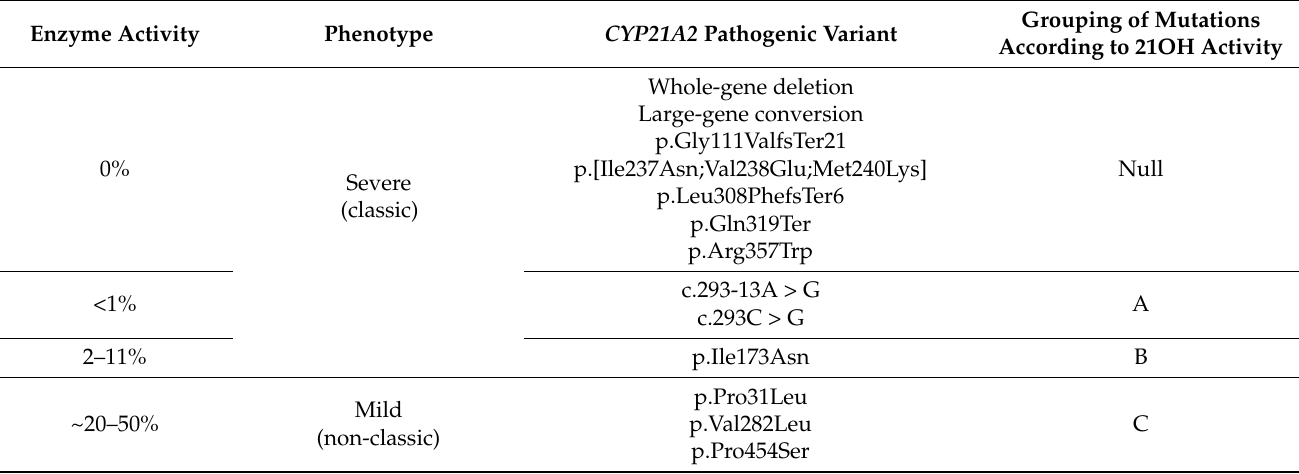
Table 1. Stratification of common CYP21A2 pathogenic variants by residual enzyme